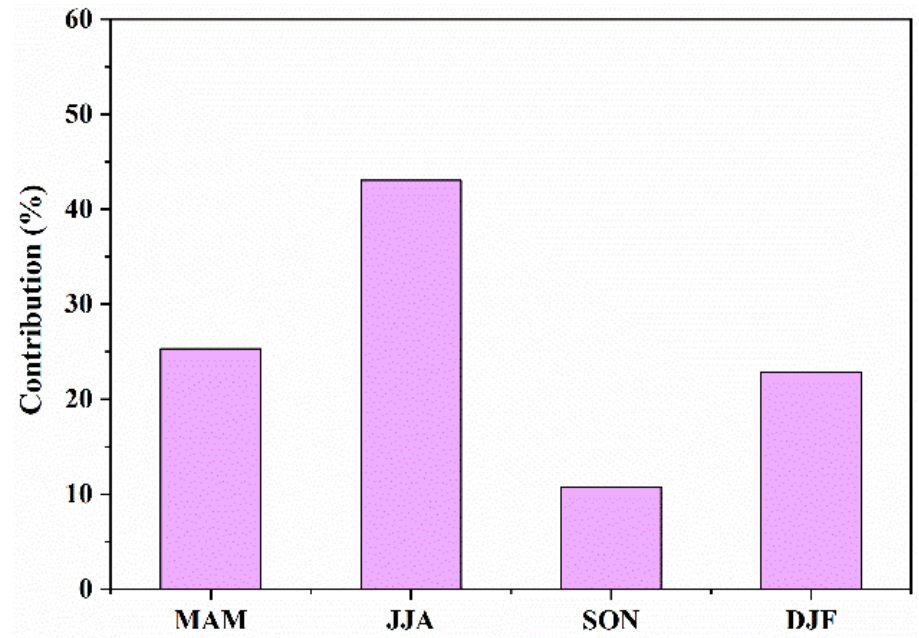
Figure 8. Seasonal contributions to global IAV of NEP.